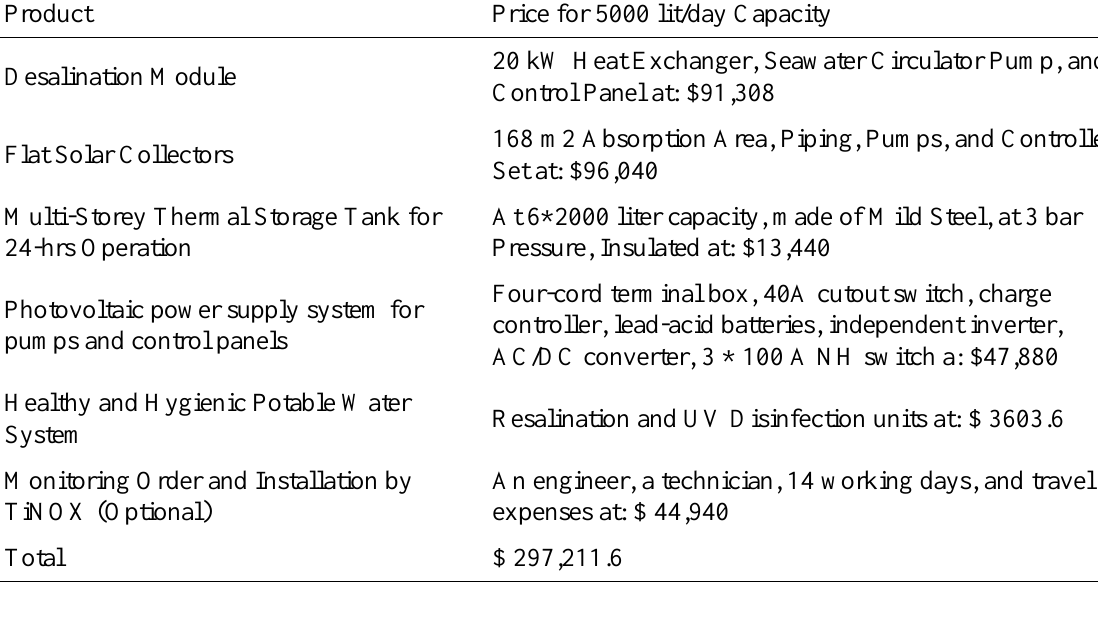
Table 5. Price of MEH Desalination Unit Manufactured by German Company of TiNOX-MAGE Product Price for 5000 lit/day Capacity